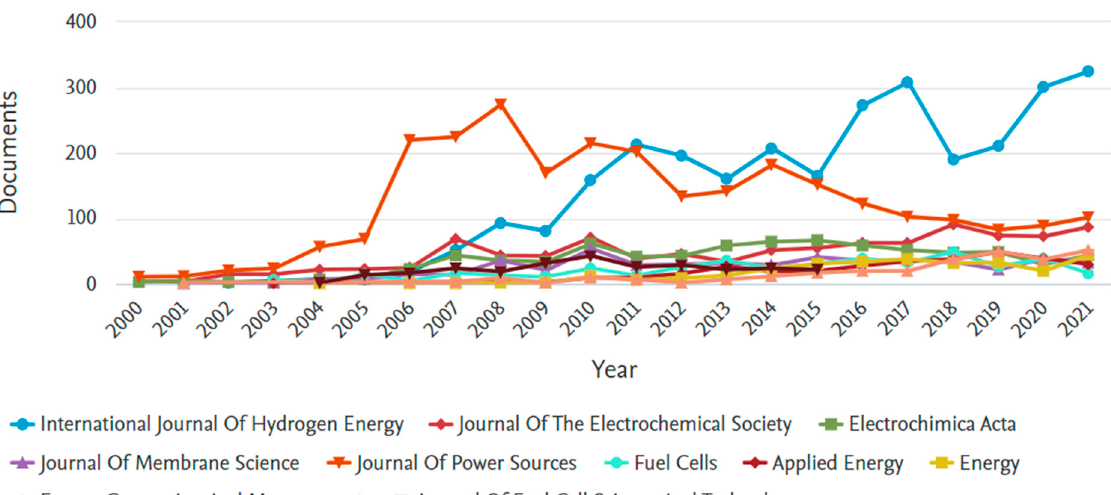
Figure 16. Top performing sources for PEMFC research from 2000 to 2021.